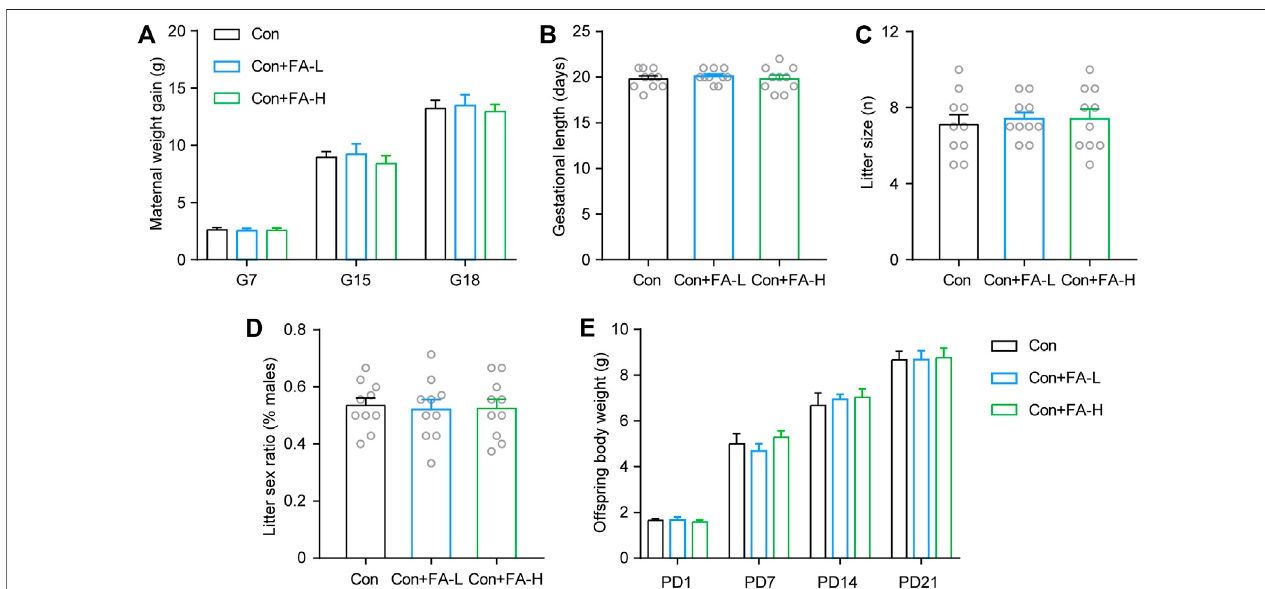
FIGURE 4 | Effects of gestational FA on pregnancy outcomes and offspring characteristics. FA administration during pregnancy had no signi fi cant effect on maternal body weight (A) , length of gestation (B) , dam litter size (C) , fraction of pup sex (D) , and offspring body weight during development (E) . Two-way repeated measures ANOVA was used to analyze the maternal body weight: F (2, 18) (cid:2) 0.2421, p (cid:2) 0.7875. Length of gestation via One-way ANOVA: F (2, 27) (cid:2) 0.2691, p (cid:2) 0.7661. Dam litter size via One-way ANOVA: F (2, 27) (cid:2) 0.1357, p (cid:2) 0.8737. Fraction of pup sex via One-way ANOVA: F (2, 27) (cid:2) 0.04937, p (cid:2) 0.9519. Two-way repeated measures ANOVA was used to analyze the offspring body weight: F (2, 18) (cid:2) 0.3204, p (cid:2) 0.7299. Data are presented as scatter points plus the mean ± SEM. n (cid:2) 10 for each group.